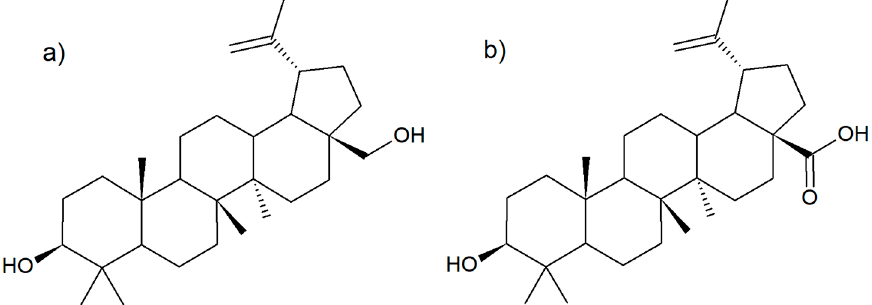
Figure 1. Chemical structure of betulin ( a ) and betulinic acid ( b ).